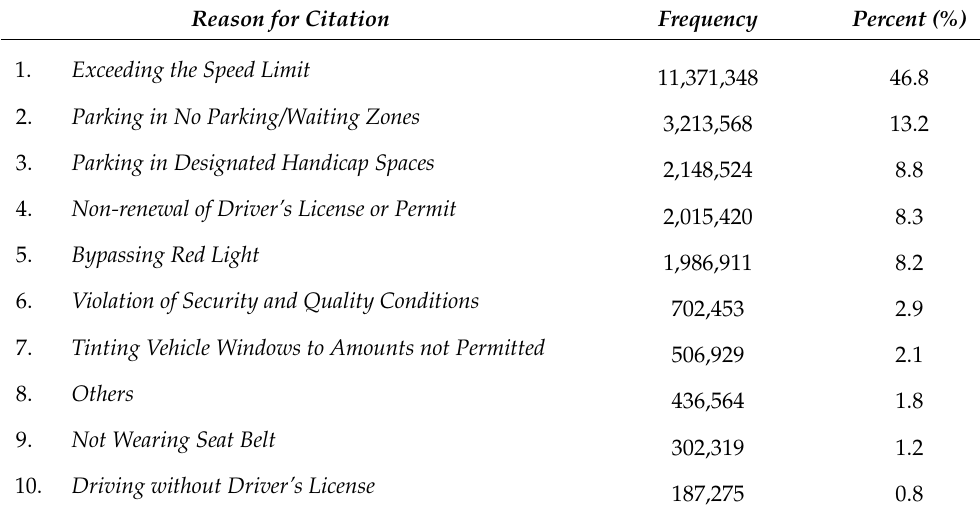
Table 2. Top 10 Reasons for Traffic Citations: